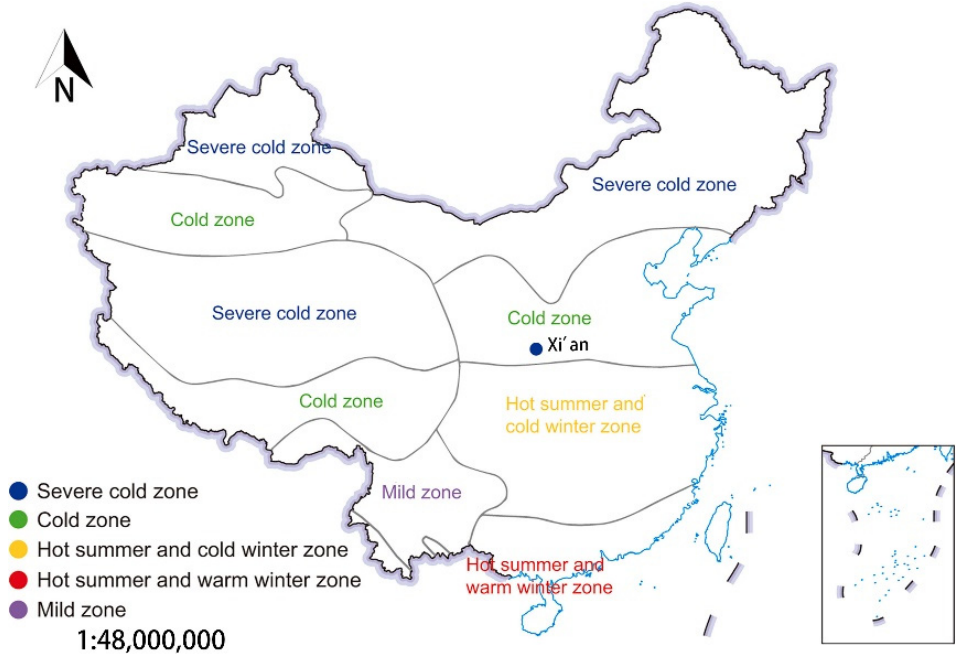
Figure 1. Location of Xi’an.